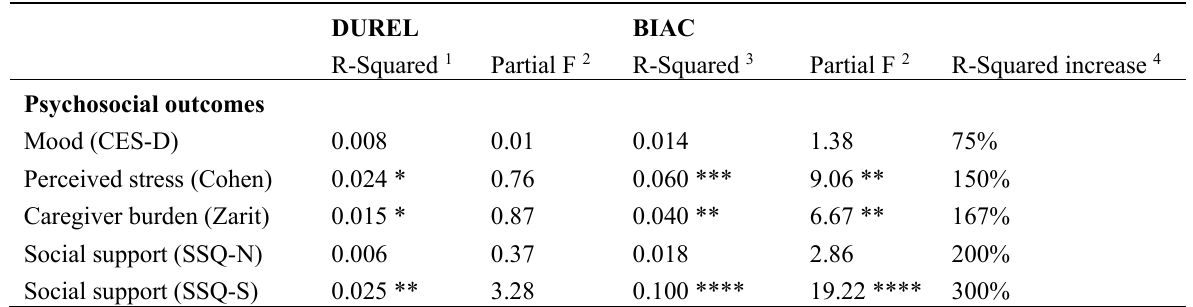
Table 1 . Comparison of BIAC and DUREL with psychosocial outcomes in 245 female U.S.